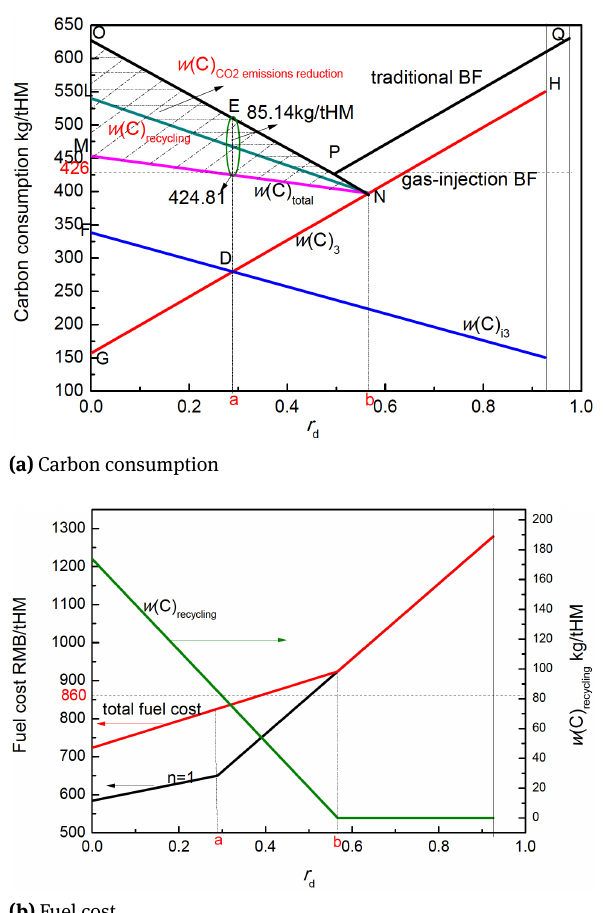
Figure 3: Effect of r d on carbon recycling and fuel cost